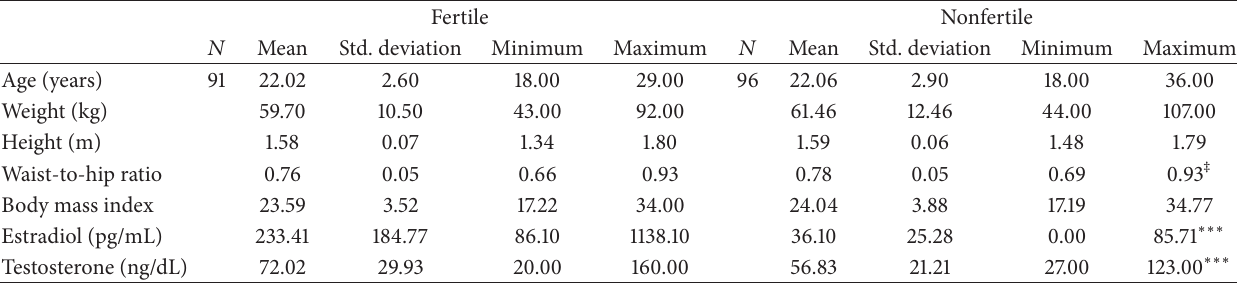
Table 1: Descriptive statistics of participants in the fertile and nonfertile phase of the menstrual